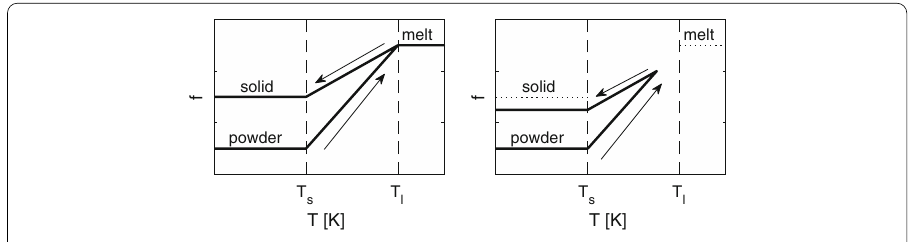
Fig. 3 Evolution of a material parameter depending on temperature history. Left: material is completely molten and consolidated. Right: temperature history stays below liquidus temperature and thus a fraction of material stays